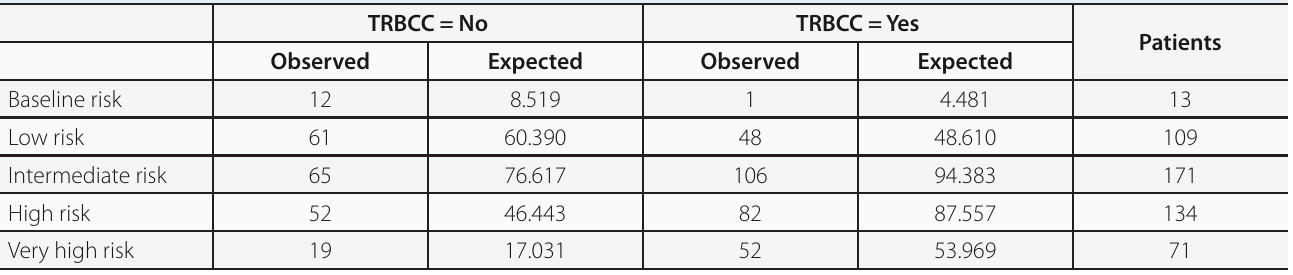
Chi-squared test = 8.64 ( P =0.034).